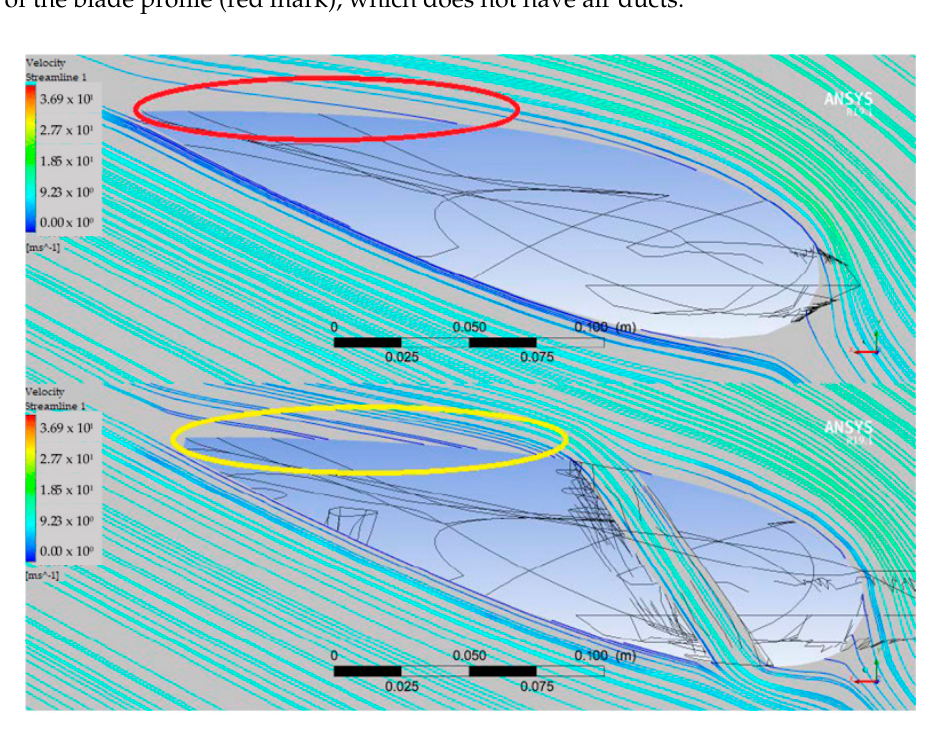
Figure 8. Streamlines in the blade profile section.